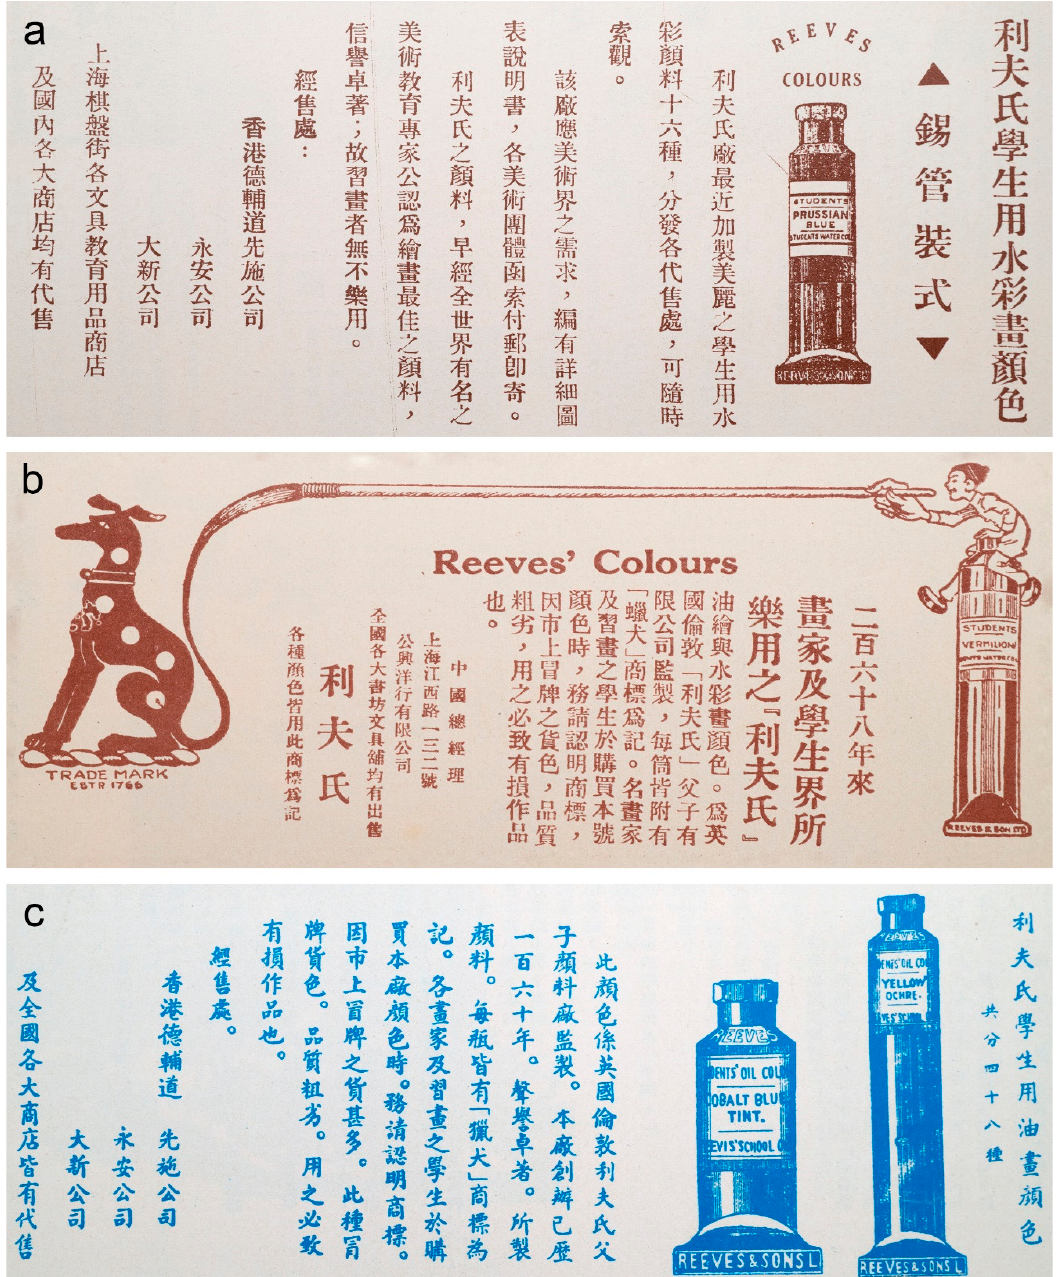
Figure 6. Advertisements by R&S warning of local imitations of their products and highlighting ( a ) Prussian blue watercolour, ( b ) vermilion watercolour and ( c ) cobalt blue oil colour.